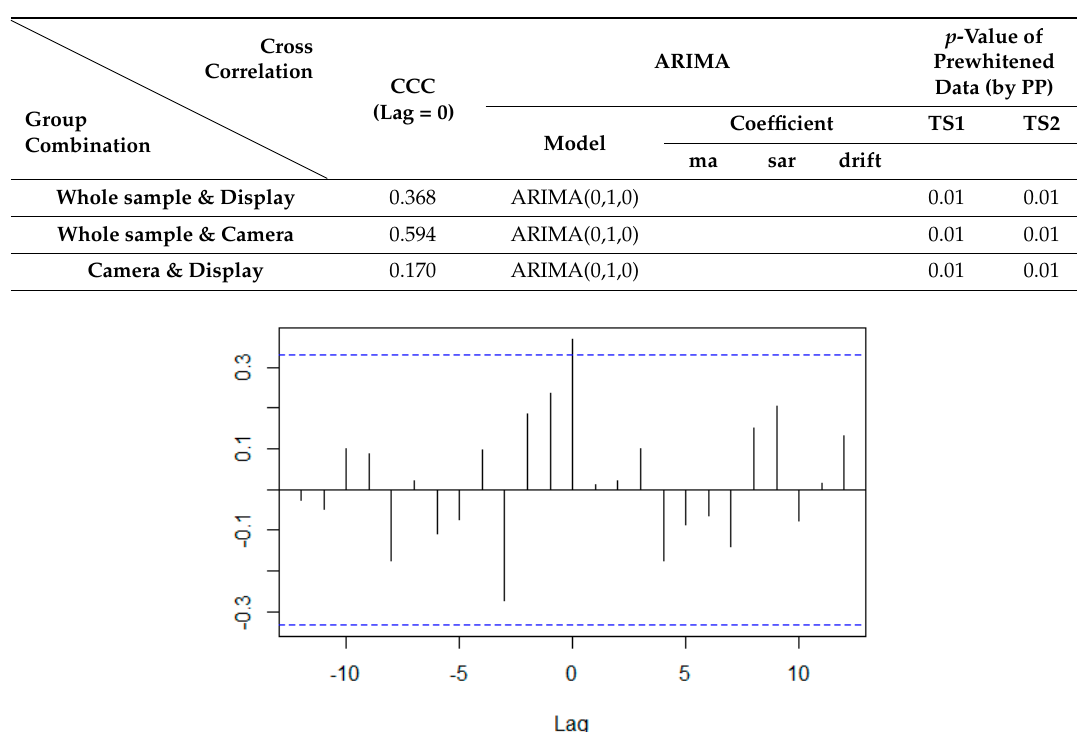
Figure 14. Cross-correlation coefficient between the average BHAR of the whole sample group and the average BHAR of the display group for Jan 2010–Dec 2012.